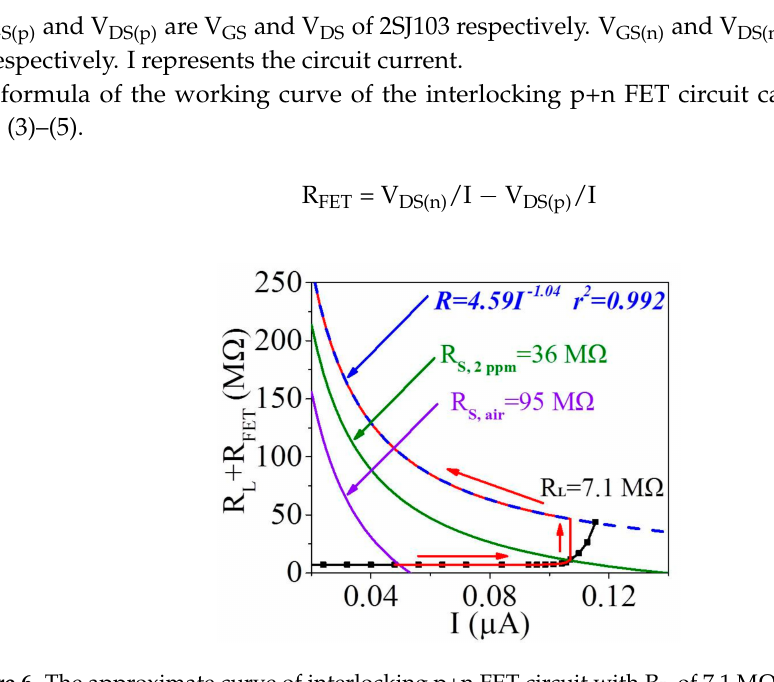
Figure 6. The approximate curve of interlocking p+n FET circuit with R L of 7.1 M Ω (red solid curve). The blue dash curve is the fitting curve of the maximum points from five solid curves of n-type FET 2SK427 circuit with R L 7.1, 10, 20, 30 and 50 M Ω respectively. And the fitting curve formula is R=4.59I -1.04 (r 2 =0.992)